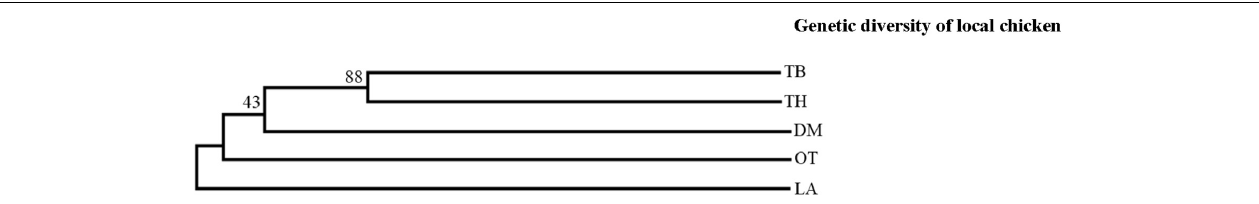
Frontiers in Genetics |